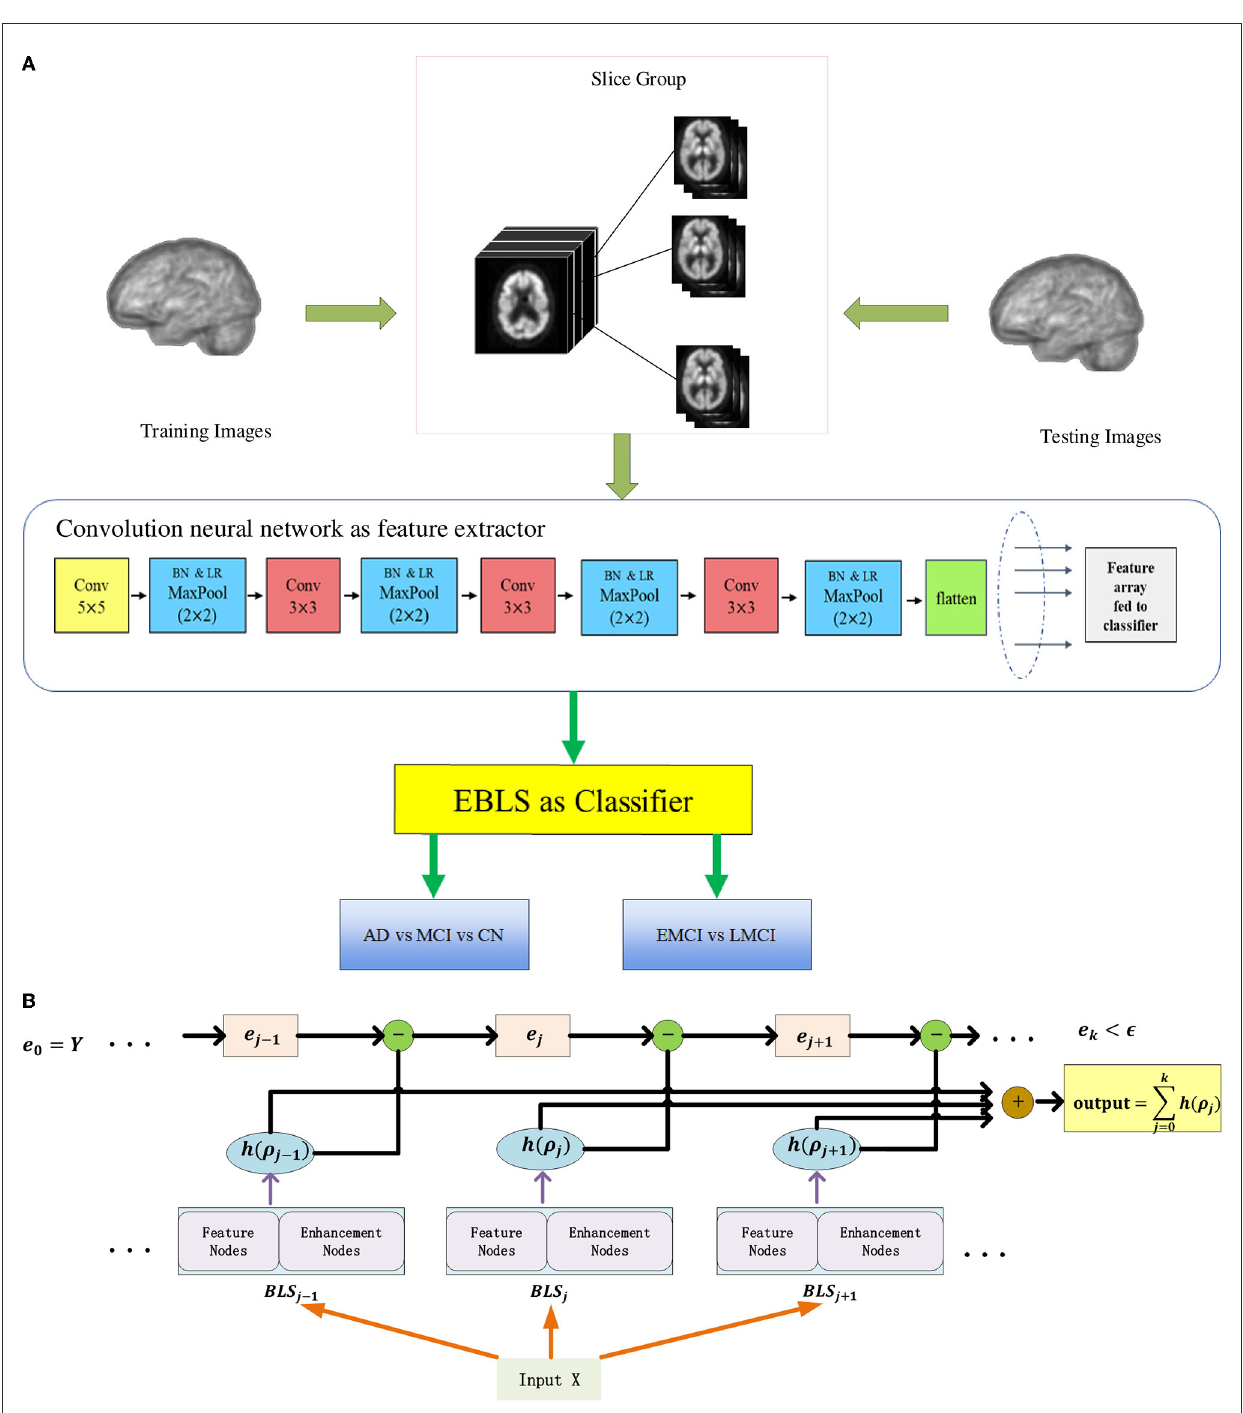
FIGURE2 Each 3D image is decomposed into groups of 2D slices at equal intervals. In the first stage, deep convolutional features are extracted from each group by 2D CNN. In the second stage, all features from each slice group are concatenated to form a compact feature vector, and fed to EBLS for final prediction. (A) The overall architecture of BLADNet. (B) The detailed structure of